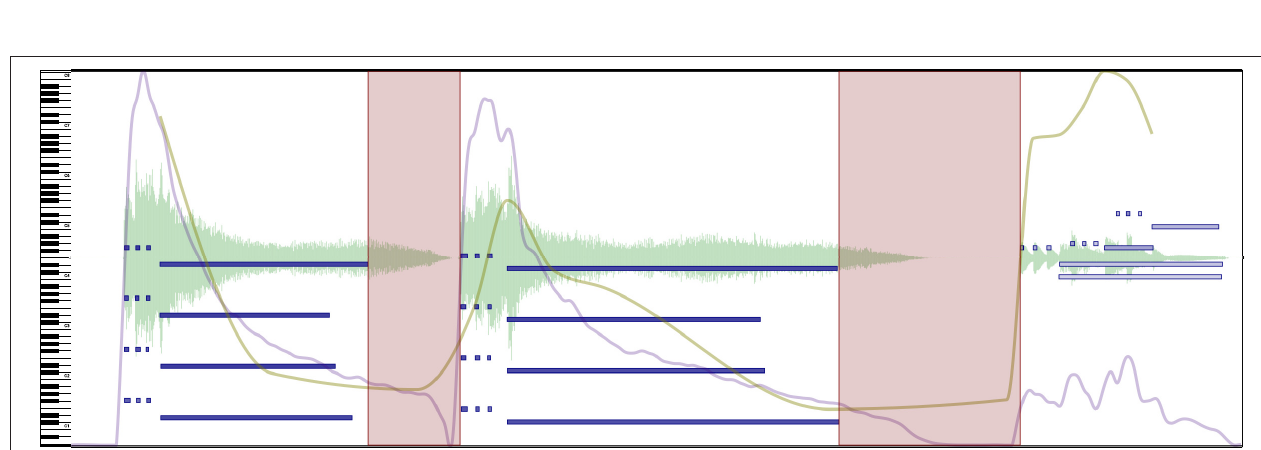
Frontiers in Psychology |